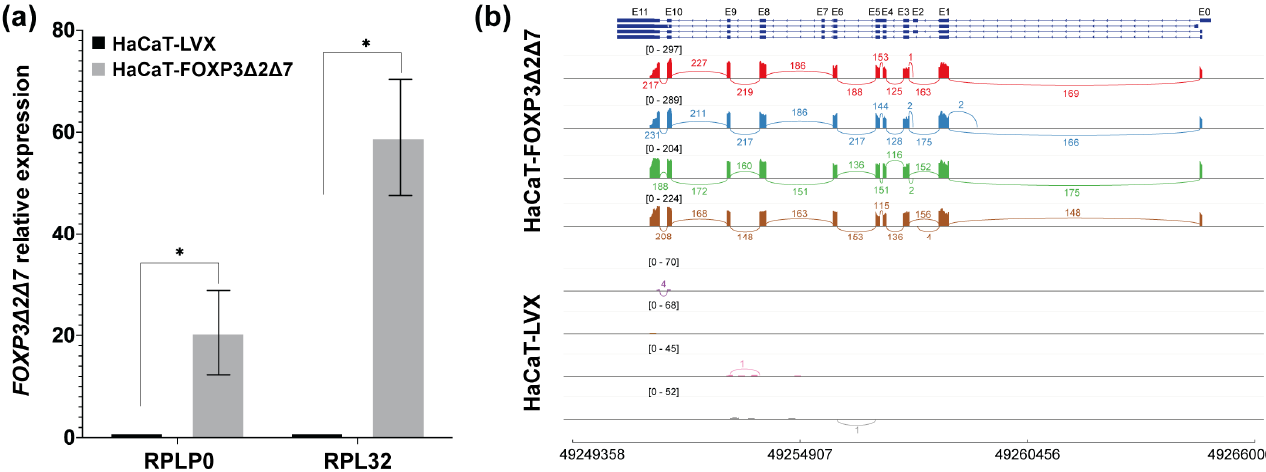
Figure 4. Validation of the establishment of the FOXP3 Δ 2 Δ 7 exogenous expression model. ( a ) FOXP3 Δ 2 Δ 7 relative expression levels were detected in the cell model by qPCR; RPLP0 and RPL32 were used as reference genes. The expression of FOXP3 in HaCaT-LVX was used as a calibrator to calculate the relative expression; ( b ) Sashimi plot of the RNAseq assays from replicates of HaCaT-FOXP3 Δ 2 Δ 7 and HaCaT-LVX cell lines, reads covering the FOXP3 genomic region are shown as colored peaks, and each numbered curved line represents an interexonic junction with the detection level. Upper blue boxes and connecting blue lines represent exonic and intronic regions. (*) depicts statistical significance with a p -value < 0.05.